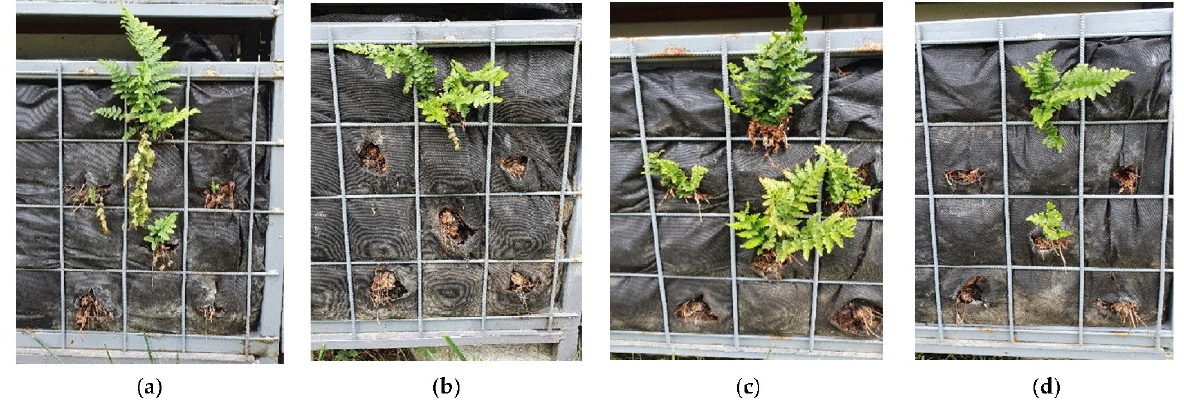
Figure 9. Polystichum aculeatum —level 1 July 2020 (13 July 2020): ( a ) north; ( b ) east; ( c ) south; and ( d ) west.